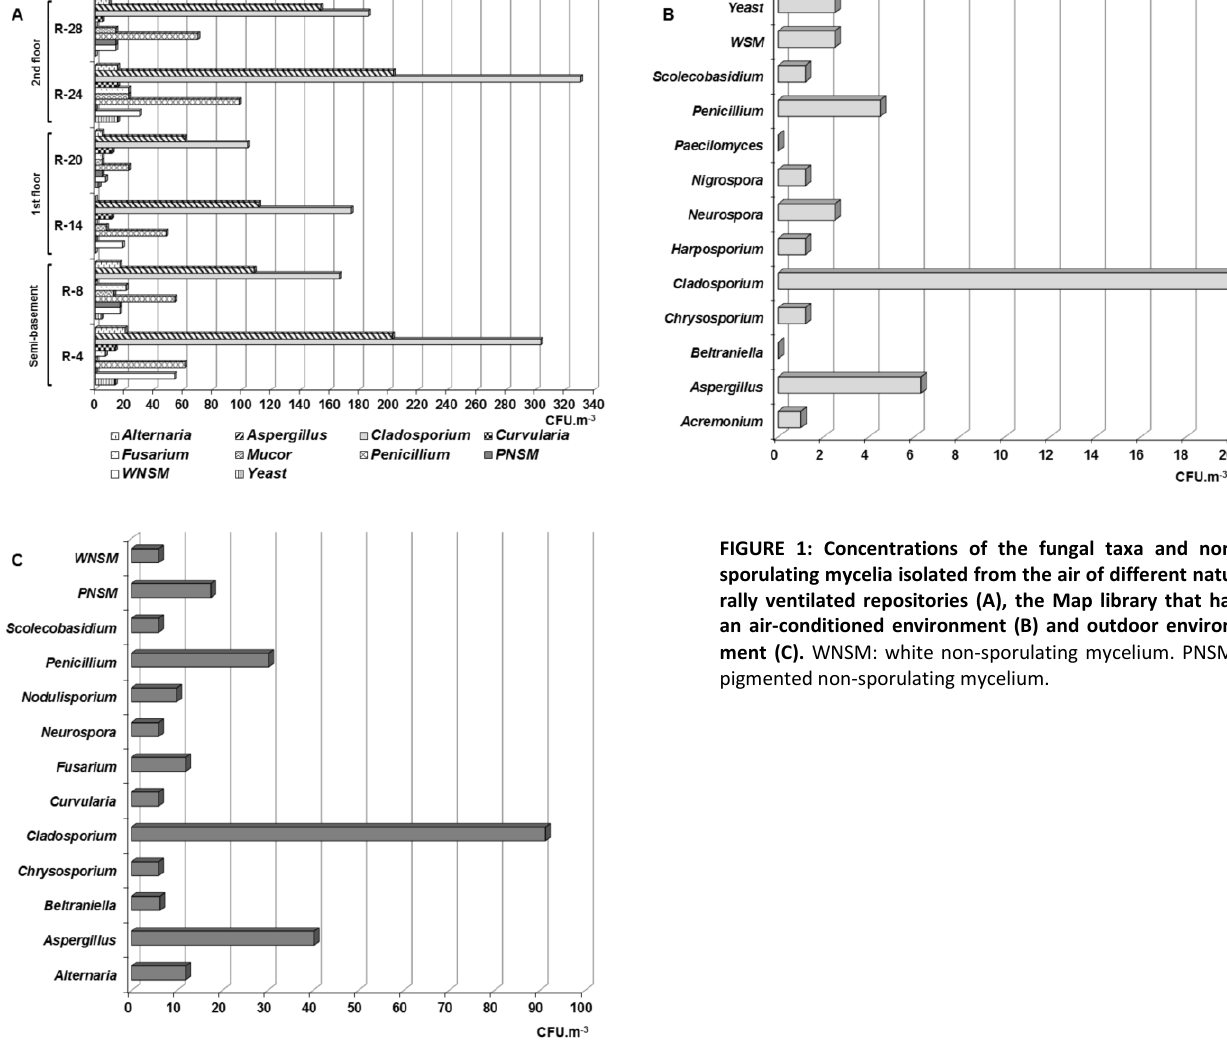
FIGURE 1: Concentrations of the fungal taxa and non- sporulating mycelia isolated from the air of different natu- rally ventilated repositories (A), the Map library that has an air-conditioned environment (B) and outdoor environ- ment (C). WNSM: white non-sporulating mycelium. PNSM: pigmented non-sporulating